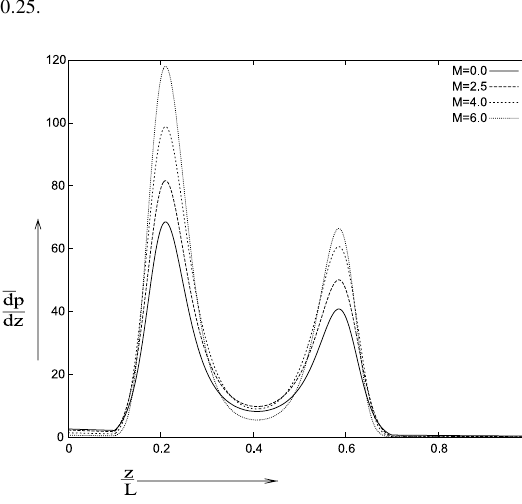
Fig.10. Variationofpressuregradient( of k when H = 0 . 2, M = 2 . 5, β = 2 . 5, when α = 0 . 09.